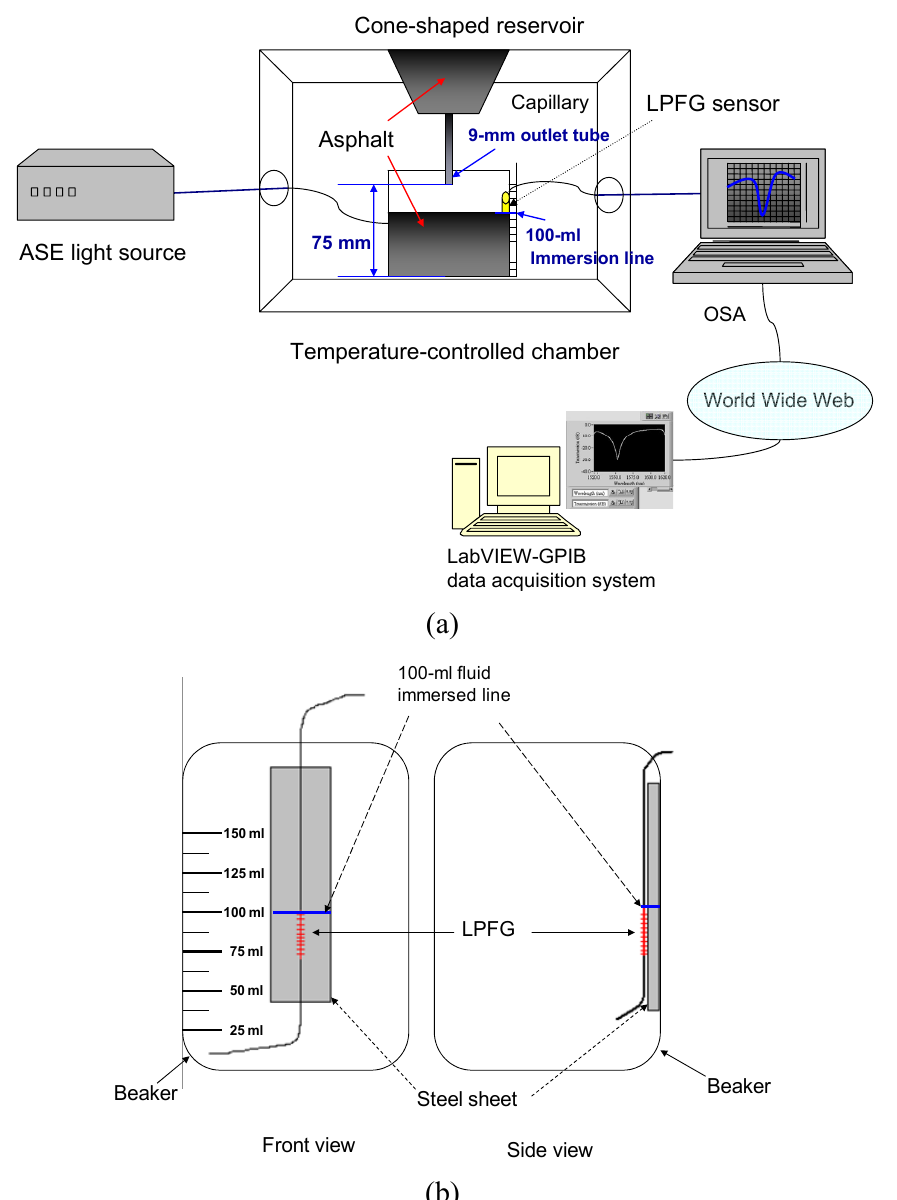
Figure 2. Schematic for (a) an LPFG-based viscometer; (b) an LPFG bonded on a steel sheet glued on the wall of a